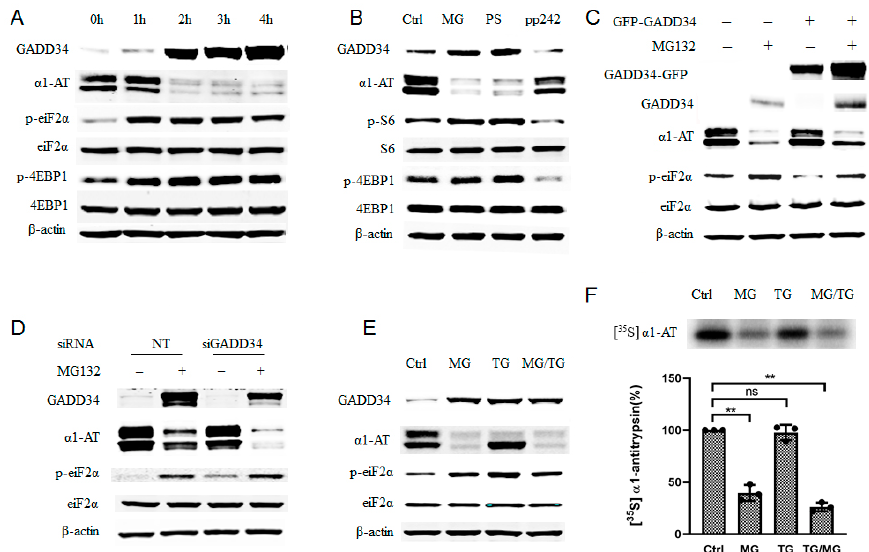
Figure 5. Proteasome inhibitor induced phosphorylation of eIF2 α only partially contributed to α 1AT translation inhibition. ( A ) C3A cells were treated with MG132 (10 µ m) for varying duration (0–4), time-dependent e ff ect of MG132 on phosphorylation of eIF2 α and 4EBP1 was detected. ( B ) C3A cells were treated with proteasome inhibitors MG132 (10 µ m), PS-341 (10 µ m) and mTOR inhibitors PP242 (0.5 µ m) for 4 h. ( C ) C3A cells were transiently transfected with empty vector or GFP tagged GADD34 for 48 h and then treated with MG132 for 4. ( D ) C3A cells were transfected with GADD34 siRNA (100 µ m) for 48 h, and then treated with or without MG132 for 4 h. ( E ) C3A cells were treated with MG132 (10 µ m) for 4 h and thapsigargin (5 µ m) for 2 h, cells lysates applied for western blot with indicated antibody. ( F ) C3A cells were treated with MG132 for 4 h, or with thapsigargin for 2 h and then labelled with [ 35 S] methionine / cysteine for 30 min. Cells lysate was then applied with immunoprecipitation using α 1AT antibody. [ 35 S] labeled α 1AT was detected by autoradiography, data represent means ± SD of three independent experiments. ** p < 0.001.